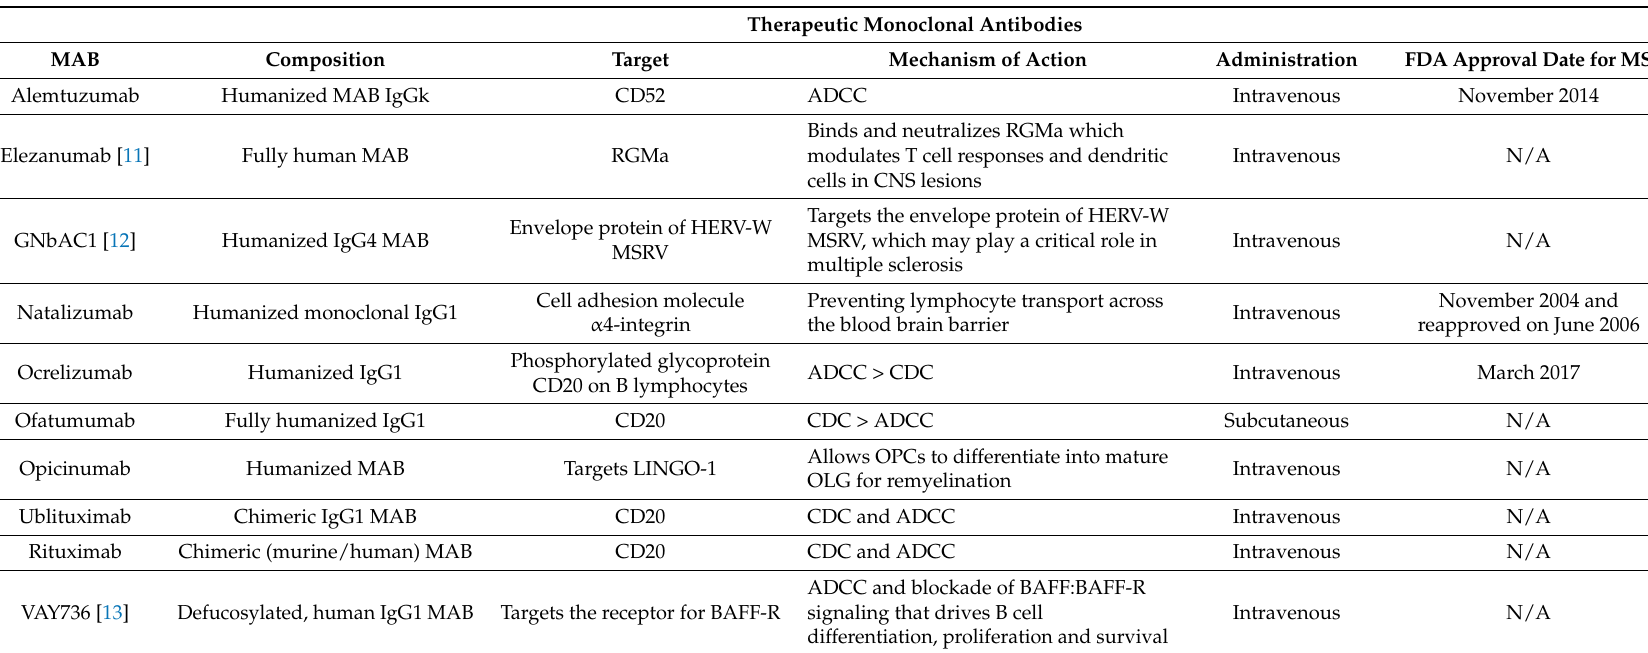
Table 1. Monoclonal antibodies currently on the market or being evaluated in phase II/III